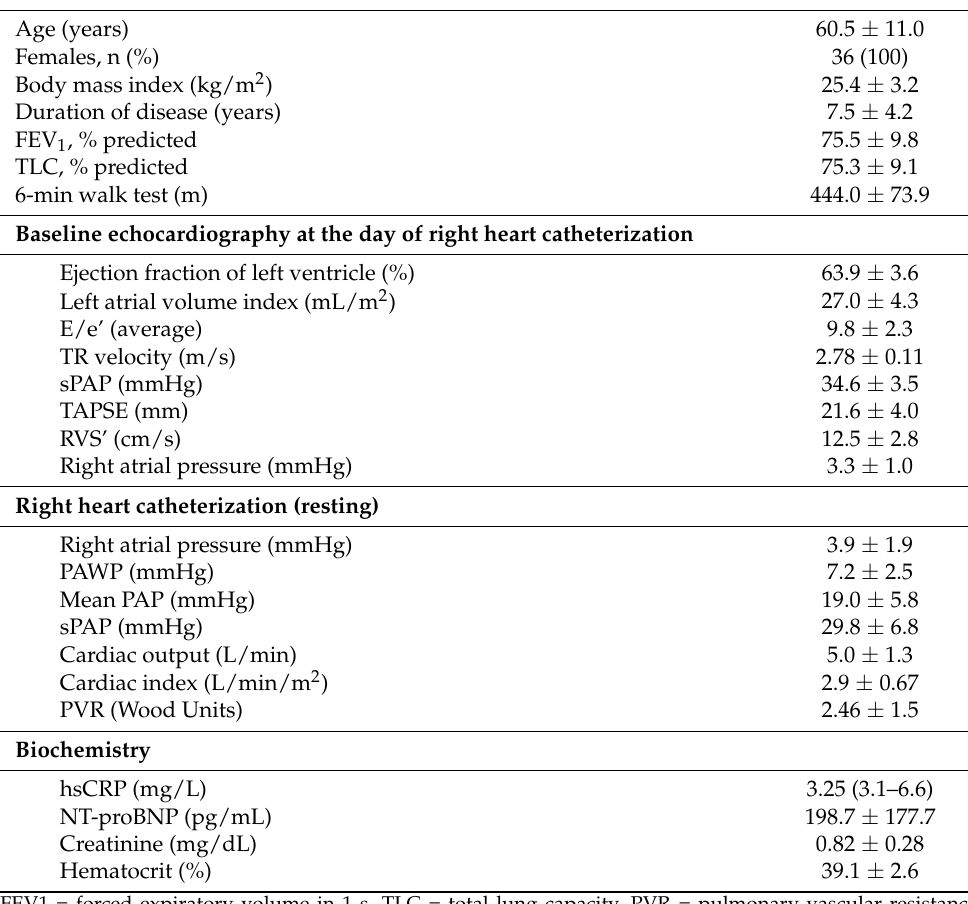
Table 1. Characteristics of the examined patients with systemic sclerosis ( n = 36).